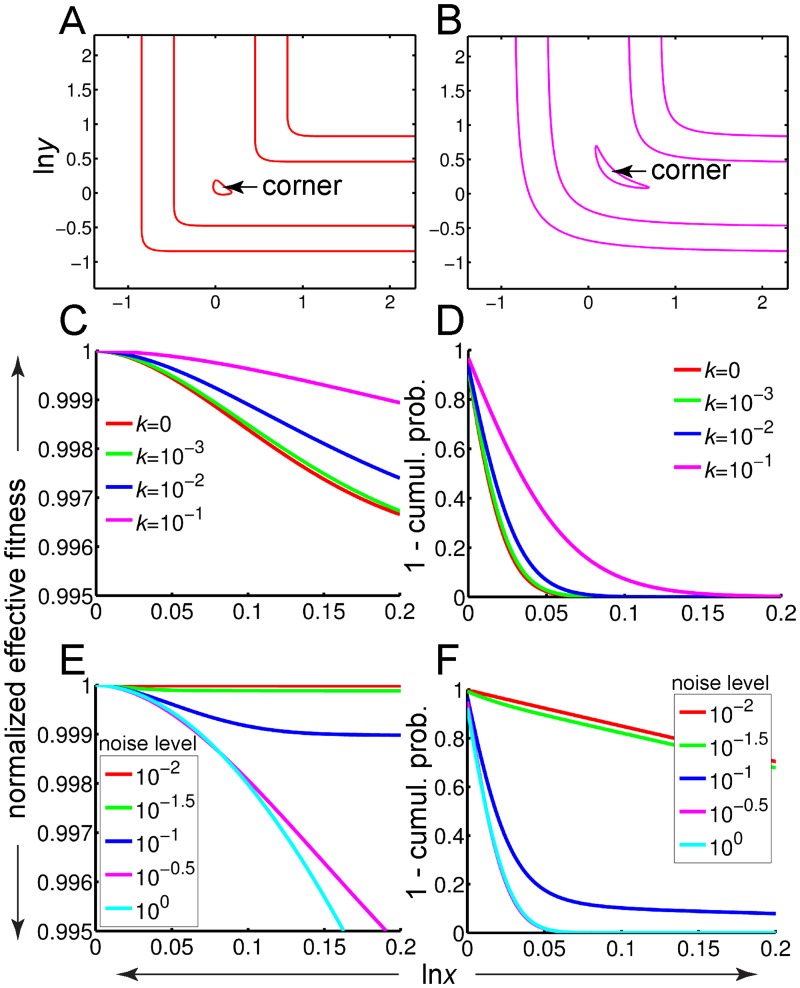
Phenotypic noise stabilizes the corner in the random-walk approximation.(A, B) Contours of the effective fitness landscape, we(x,y), for k = 0 (A) and k = 0.1 (B). Effective fitness resulting from phenotypic noise is computed at any given position by averaging neighboring fitness values using a rotationally symmetric normal distribution (on log-transformed input values) with a standard deviation (“noise level”) of 0.2. Contour lines correspond to we = 0.5, 0.8, 0.99. (C) Normalized effective fitness profiles, we(x’)/we(0), along the pseudo-horizontal arm of the optimal fitness ridge, projected onto the x-axis and shifted horizontally so as to align the corners. x’ = lnx. (D) Probabilities that the population is found at least the indicated distances from the corner. (E, F) Same as panels C and D, respectively, except now the noise level is changed while the interaction constant is kept fixed at k = 10−4. Throughout, population size is N = 5000, optimal phenotypic value is zopt = 1 and selection factor is s = 1.